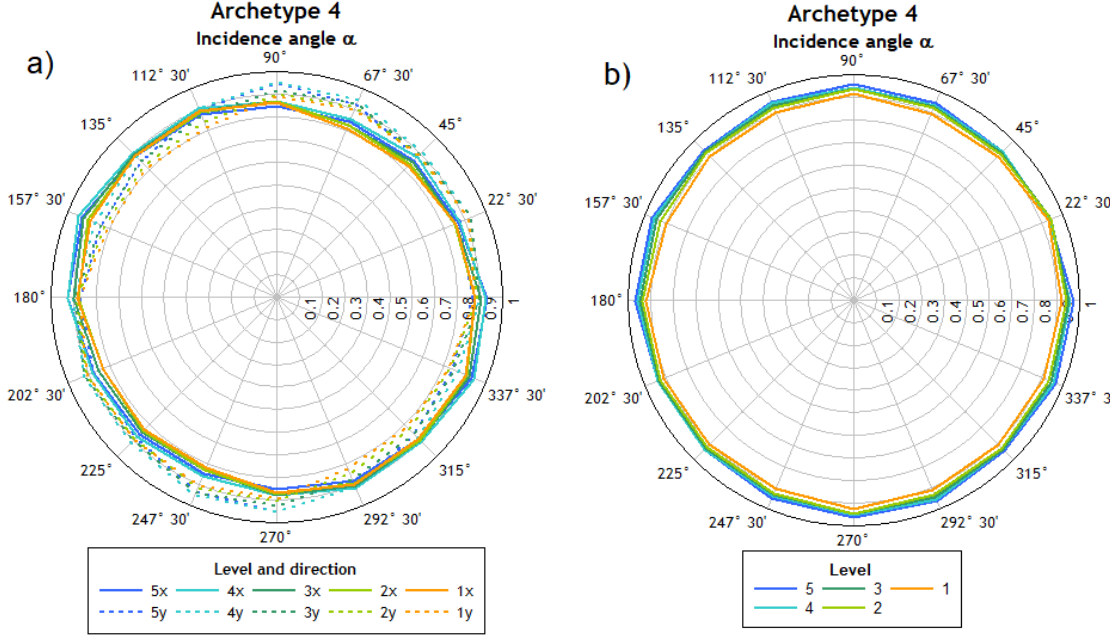
Figure 14. Mean interstory drift normalized for Archetype 4 per story, ( a ) without and ( b ) with SRSS